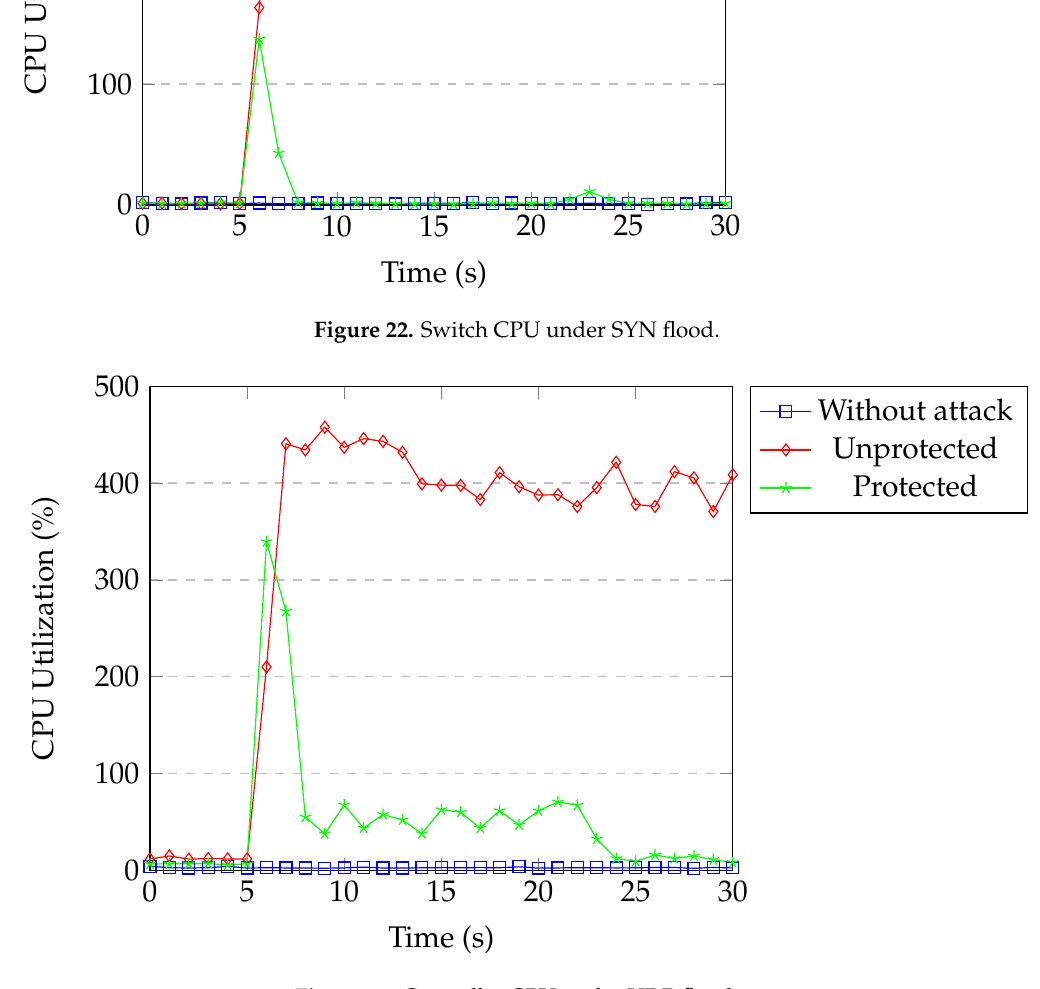
Figure 23. Controller CPU under UDP flood.